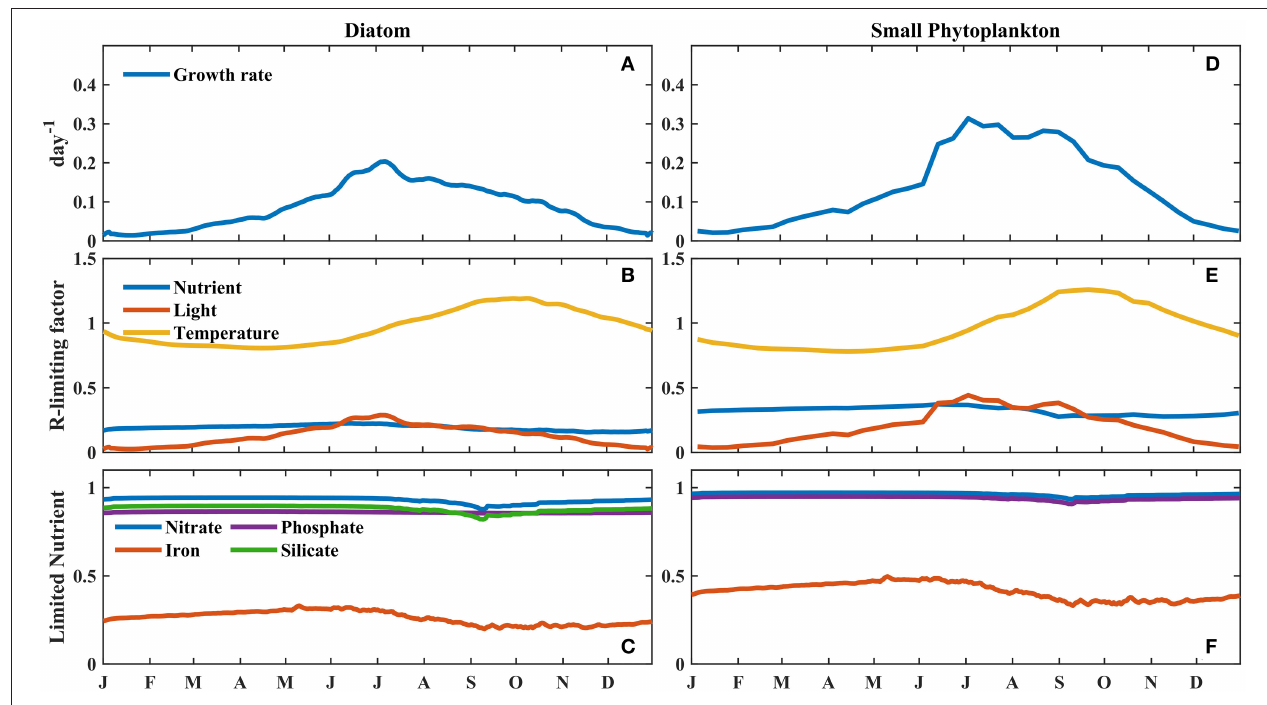
FIGURE 7 | Modeled seasonal cycle of the vertically integrated (A,D) growth rate, (B,E) regulating factors, and (C,F) limiting nutrient factors for phytoplankton, weighted by the phytoplankton biomass at Stn. Papa. (A–C) are for small phytoplankton; (D–F) are for diatoms.